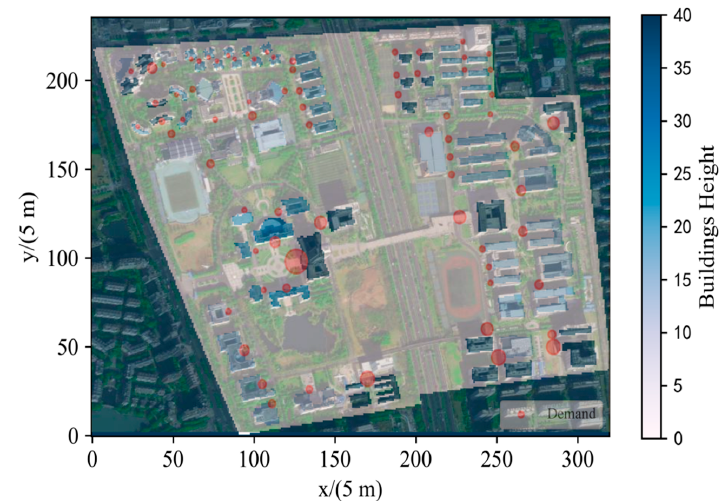
Figure 9. Distribution of logistics demand. Table 5. Distribution and volume of logistics demand.